Question: Write a single sentence explaining what this figure depicts.
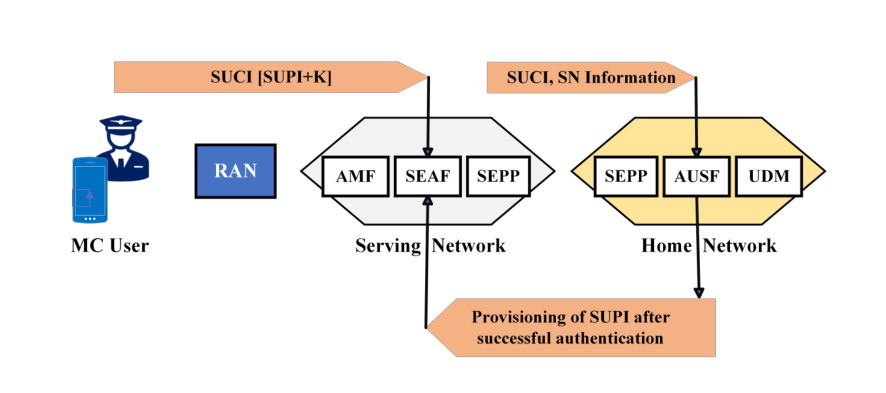
Answer: Authentication process during the 5G registration procedure